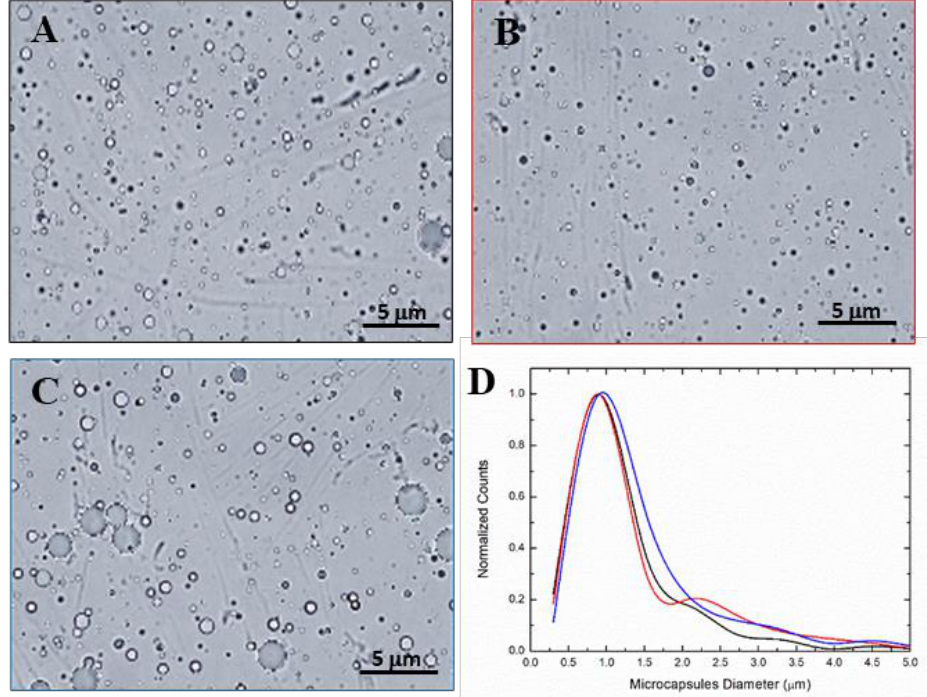
Figure 5. Optical microscopy images of OG mc , embedding 50 µ L SO at different sonication times: ( A ) 30 s, ( B ) 45 s and ( C ) 60 s. ( D ) Comparison of the normalized size distribution of OG mc obtained after 30 s (black line), 45 s (red line) and 60 s (blue line) of sonication.